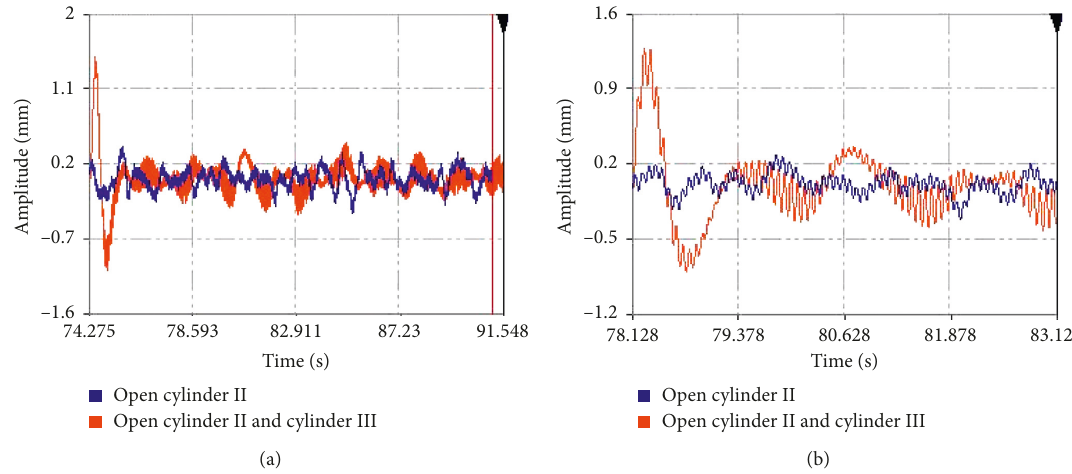
Figure 11: Vertical displacement of the bearing housing of cylinder II. (a) Time-vertical displacement curve. (b) Enlarged